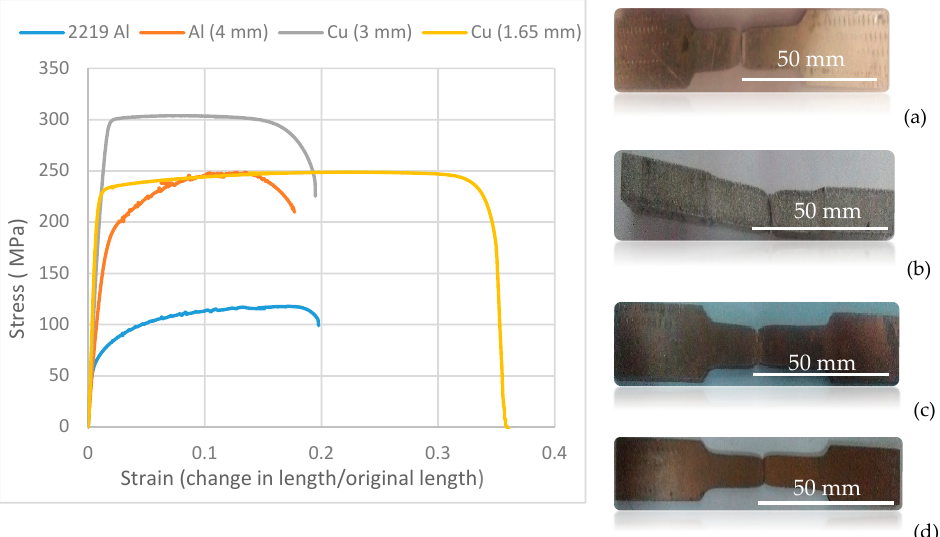
Figure 2. Stress–strain curve for: ( a ) 2.15 mm 2219 Al, ( b ) 4 mm 1060 Al, ( c ) 3 mm Cu, and ( d ) 1.65 mm